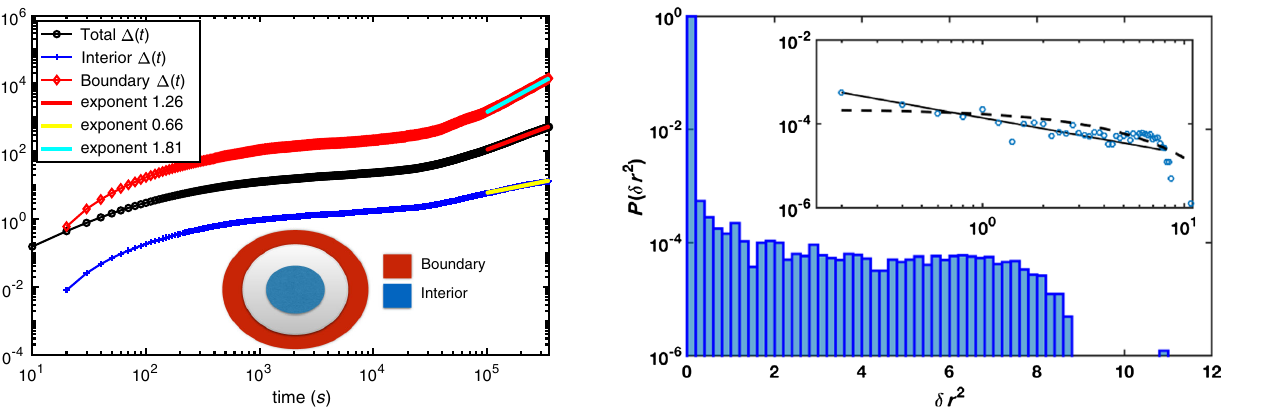
FIG. 11. Plot of the mean-square displacement Δ ð t Þ for interior, boundary, and the total initial cells. The interior cells exhibit subdiffusive behavior through their entire lifetime. The cells at the boundary show subdiffusive motion at intermediate times, followed by superdiffusive behavior at long times. The interior Δ ð t Þ is multiplied by 0.1 and the boundary Δ ð t Þ by 10 for clarity. The inset shows the way we have divided the tumor into the interior and boundary regions. Here τ ¼ τ